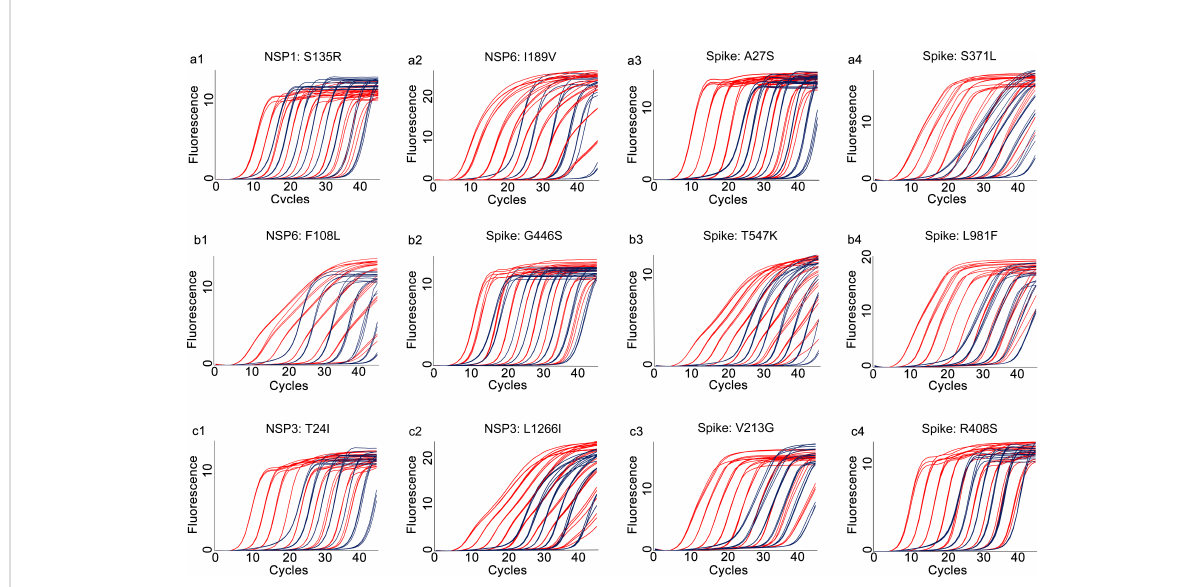
FIGURE 5 Ampli fi cation curves for the developed multiplex allele-speci fi c qRT-PCR assays against the mutated genes of SARS-CoV-2. The viral mutated genes (NSP1, NSP3, NSP6 and Spike) covering all the mutations listed in Table 1 were in vitro transcribed and 10-fold diluted from 10 7 copies/ reaction (8.59×10 7 , 8.83×10 7 , 6.92×10 7 , 2.45×10 7 for NSP1, NSP3, NSP6 and Spike, respectively) to 10 -1 copies/reaction. Two parallel reactions targeting the prototype allele and the mutated allele of the developed assays were performed by using the in vitro transcribed and serially diluted mutated RNA as template. The ampli fi cation curves for the mutated allele targeting reactions (in red) were then merged with those of the corresponding prototype allele targeting reactions (in dark blue). The ampli fi cation curves for assay 1 [NSP1: S135R (a1), NSP6: I189V (a2), Spike: A27S (a3), and Spike: S371L (a4)], assay 2 [NSP6: F108L (b1), Spike: G446S (b2), Spike: T547K (b3) and Spike: L981F (b4)], assay 3 [NSP3: T24I (c1), NSP3: L1266I (c2), Spike: V213G (c3), and Spike: R408S (c4)] are